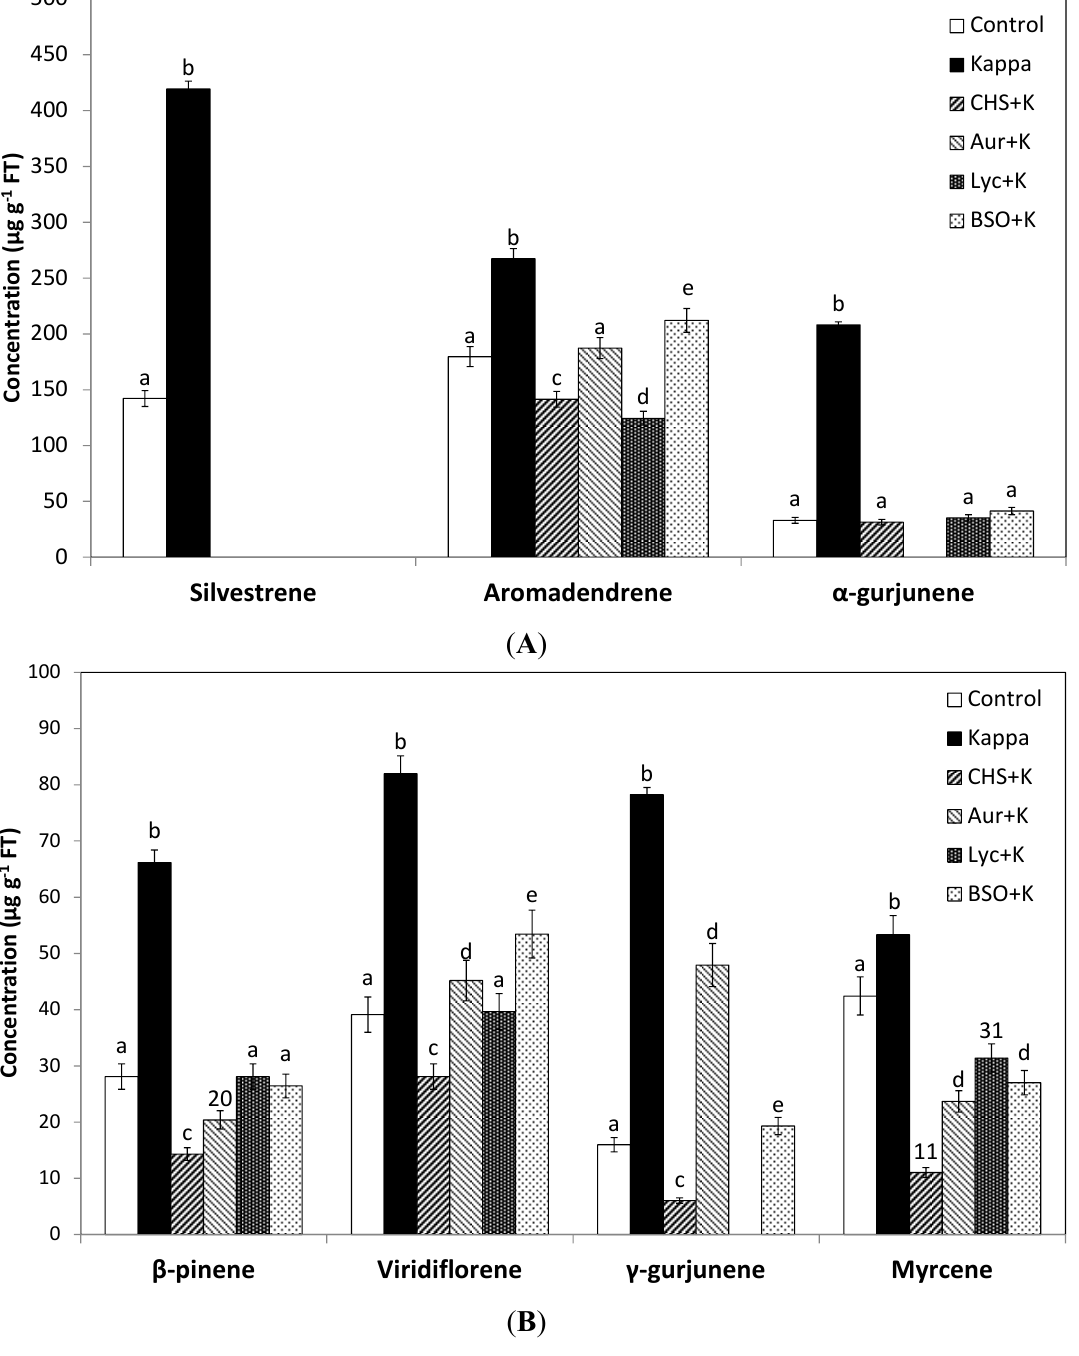
Figure 3. Level of terpenoids ( A – C ) that increased in leaves of Eucalyptus trees treated in control condition (control), treated with OC kappa at 1 mg·mL − 1 (Kappa) or tretade with CHS-828 and OC kappa (CHS+K), auranofine and OC kappa (Aur+K), lycorine and OC kappa (Lyc+K) and buthionine sulfoximine and OC kappa (BSO+K) and cultivated for 4 months. Bars represent mean values of three independent experiments and letters significant differences ( p <